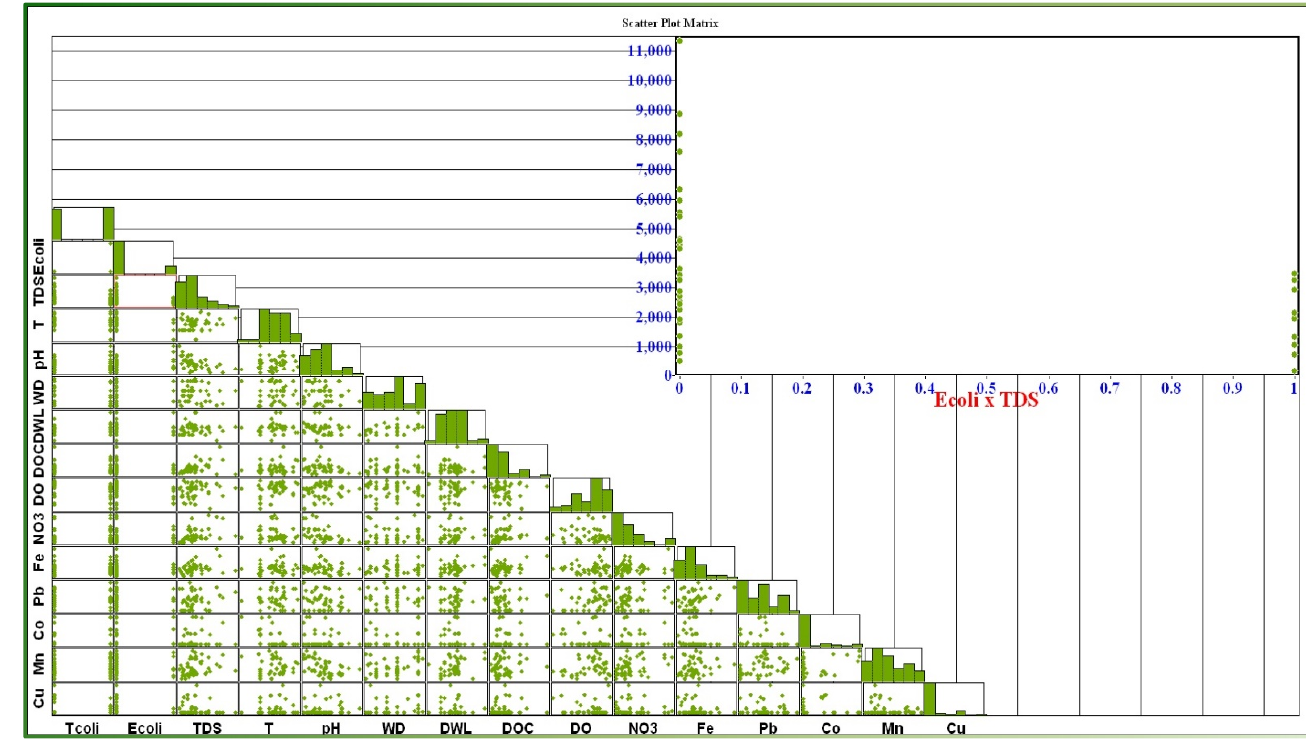
Figure 4. Scatter box plot matrix of the interplaying factors